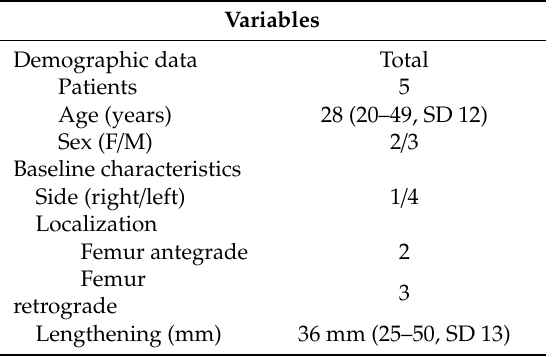
Table 1. Demographic data and baseline characteristics.